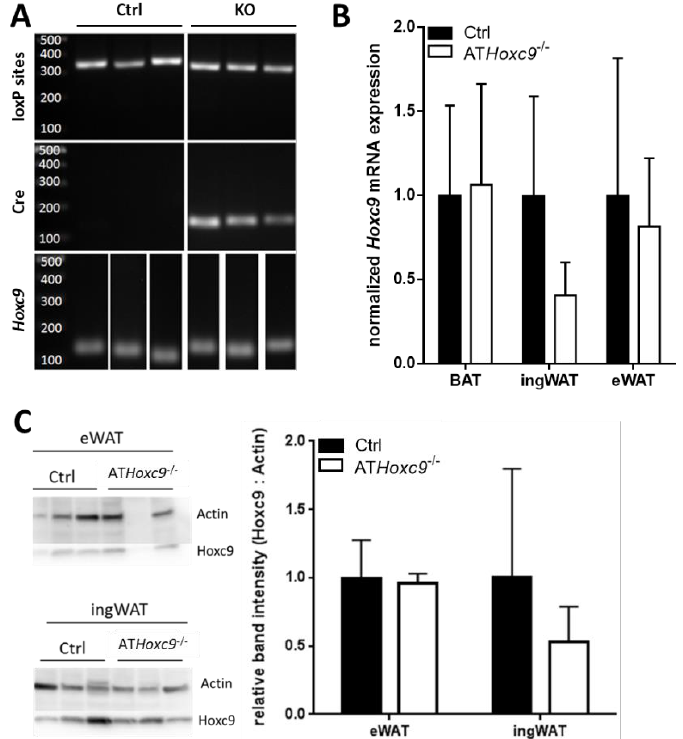
Figure 2. Detection of Hoxc9 in adipose tissue. ( A ) Agarose gel electrophoresis of PCRs performed with genomic DNA isolated from inguinal white adipose tissue (ingWAT) of control ( Hoxc9 lox/lox and Fabp4 -Cre - ) and AT Hoxc9 -/- ( Hoxc9 lox/lox and Fabp4 -Cre + ) mice. Both control and AT Hoxc9 -/- mice showed a heterozygous Hoxc9 lox/lox product of 324 bp representing floxed Hoxc9 exons 2 and 3 (loxP sites). Products of ~100 bp revealing Fabp4- Cre recombinase were just present in AT Hoxc9 -/- animals (Cre). Finally, a product of 115 bp illustrating a DNA fragment in between the Hoxc9 intron 1 exon 2 junction was detectable in both control and AT Hoxc9 -/- mice (Hoxc9). ( B ) Hoxc9 gene expression patterns in murine AT depots were measured using LightCycler 480 and SybrGreen I assay relative to 36B4 expression and normalized to Hoxc9 lox/lox animals. Expression values were calculated according to Pfaffl et al. (2001) [12]. n = 8 per tissue and genotype. Both sexes and diets included. ( C ) Protein levels in epididymal white AT (eWAT) and ingWAT were determined using western blot followed by densitometric analysis using GeneTools 4.3.8 software (Syngene, Cambridge, U.K.). Hoxc9 band intensities are presented relative to actin levels and normalized to Hoxc9 lox/lox mice.